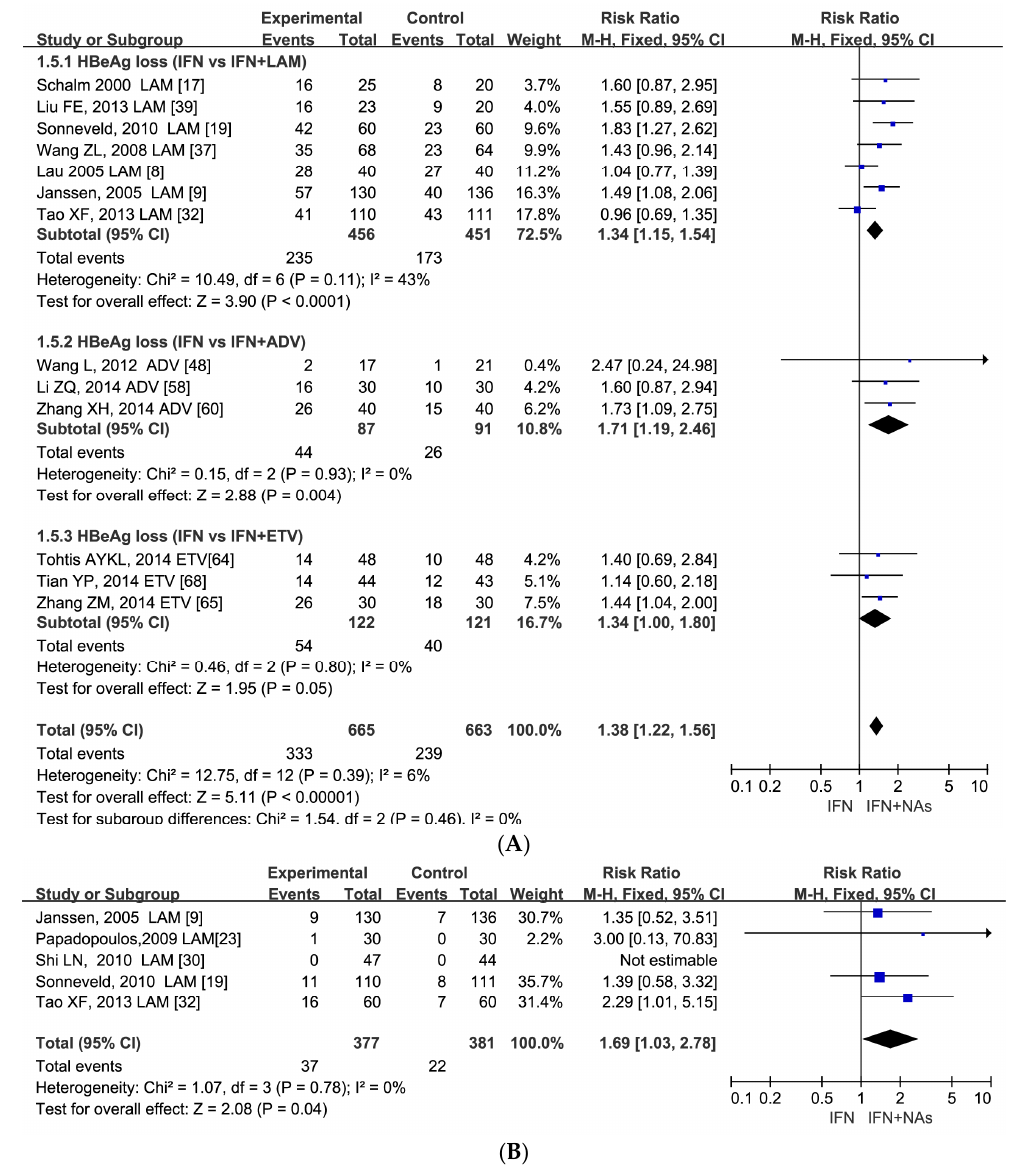
Figure 3. Forest plots of 13 studies including 1328 patients in HBeAg loss rate (RR = 1.38, 95% CI: 1.22–1.56, p < 0.00001) ( A ) and HBsAg loss rate in five studies including 758 patients between